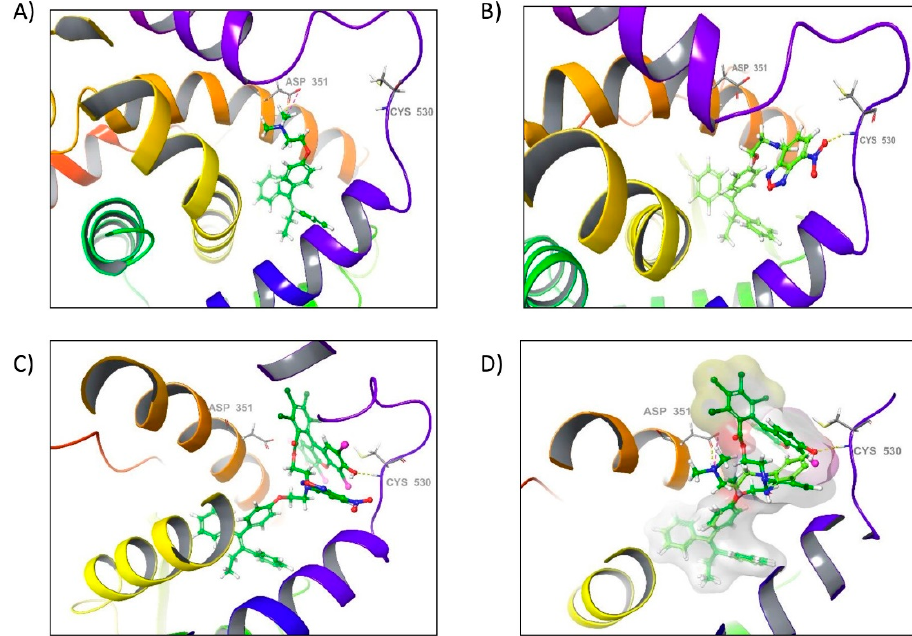
Figure 3. Best Docking poses for TX ( A ), FLTX1 ( B ), and FLTX2 ( C ) in the human ER α ligand binding domains (LBD). ( D ) Overlapped docking poses of TX and FLTX2 within the human ER α LBD.